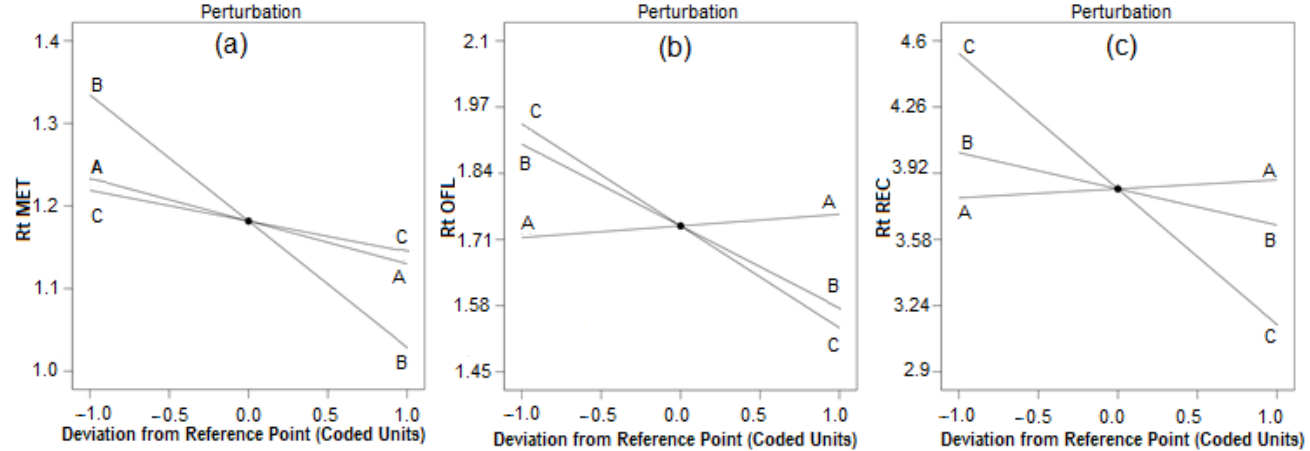
Figure 2. Perturbation plot for ( a ) metronidazole, ( b ) ofloxacin, and ( c ) racecadotril. Chromatographic parameters (A) pH (5.5, 6, and 6.5), (B) flow rate (1.0, 1.2, and 1.4 mL/min) and (C) concentration of acetonitrile (50, 55 and 60%).